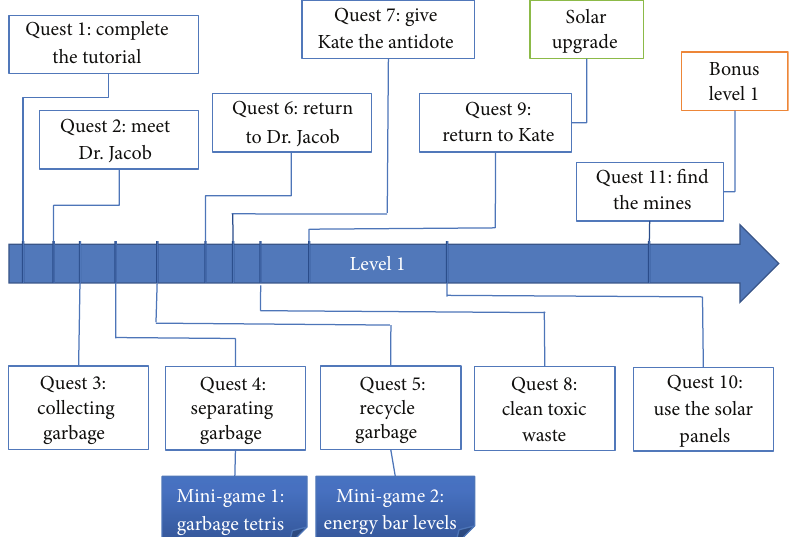
Figure 8: Workflow of the first level of the game, where we can see the several quests and the two learning mechanisms that run in parallel to main game (i.e., two